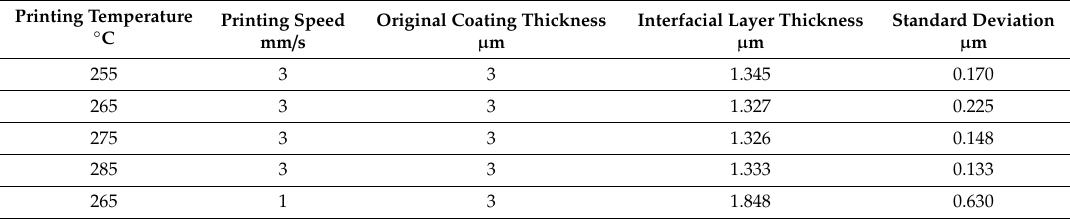
Figure 6. Image of fiber-matrix interface of the composite specimens ( a ) S1 and ( b ) S3 with higher magnification BSE. Table 5. Thickness of interfacial zone.